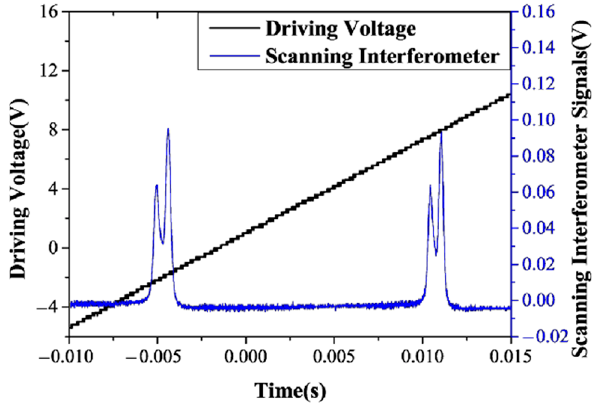
Figure 21. Oscillating spectrum of dual-frequency laser (blue trace) and triangular-wave voltage (black trace) [29].